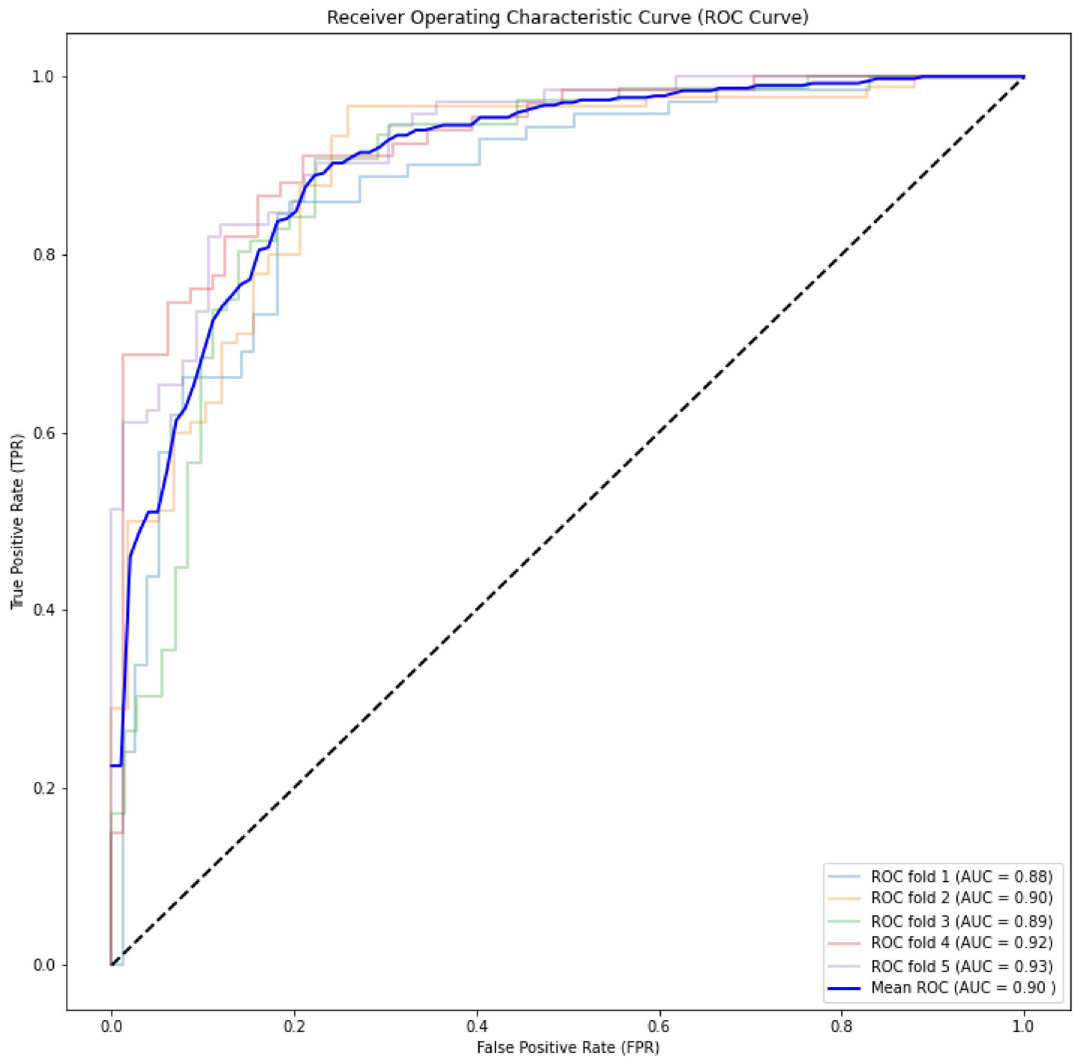
Figure 3. ROC curve for ACP-240 dataset for the fivefold cross-validation on the experiment. Similar to the results reported for ACP-740 dataset, we constantly achieve very high Area Under the Curve (AUC)